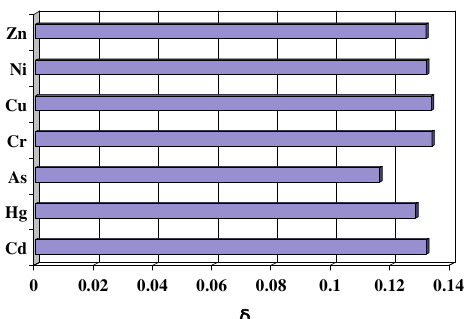
Fig. 17. The relative difference of national annual pollutant emission from motor vehicles in Poland comparing 2016 to 2015